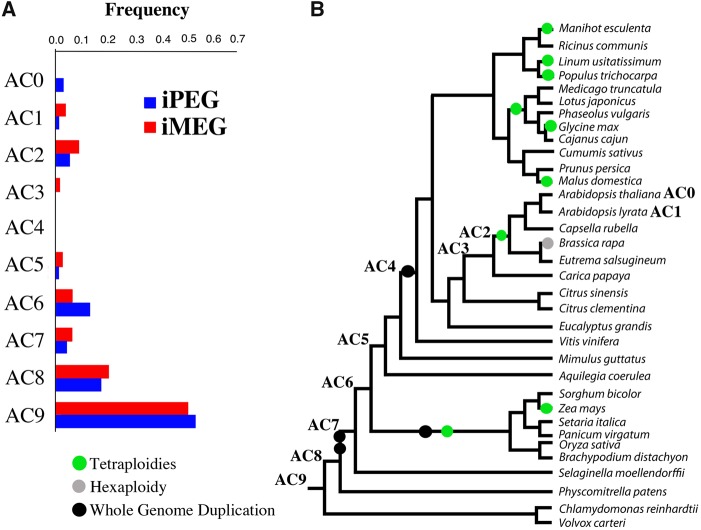
Phylogeny of the 34 species included in our analyses and the age distribution of iMEGs and iPEGs. (A) This shows the frequency of age class (AC) for the iMEGs and iPEGs tested. AC0, Arabidopsis thaliana specific; AC1, A. lyrata; AC2, Brassicaceae; AC3, Brassicales-Malvales; AC4, Rosid; AC5, Eudicot; AC6, Angiosperm; AC7, Tracheophyte; AC8, Embryophyte; AC9, Viridiplantae. (B) Consensus phylogenetic relationships of all 34 species; the phylogenetic position of the age classes and the known whole genome duplication events for the species included in the study are also highlighted (Vanneste et al. 2014).